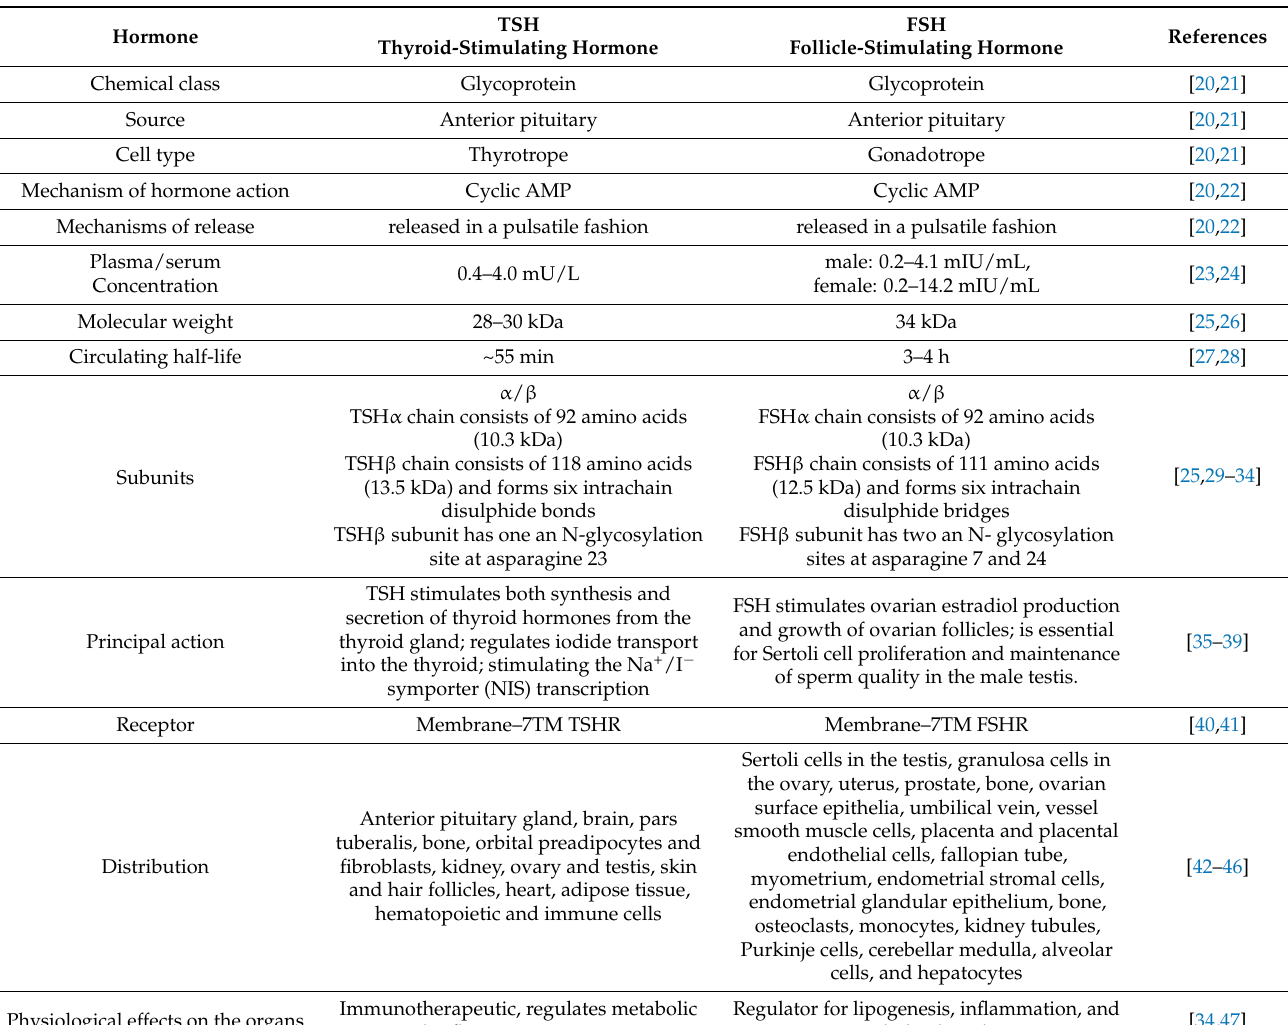
Table 1. Comparison of the structure and function of TSH and